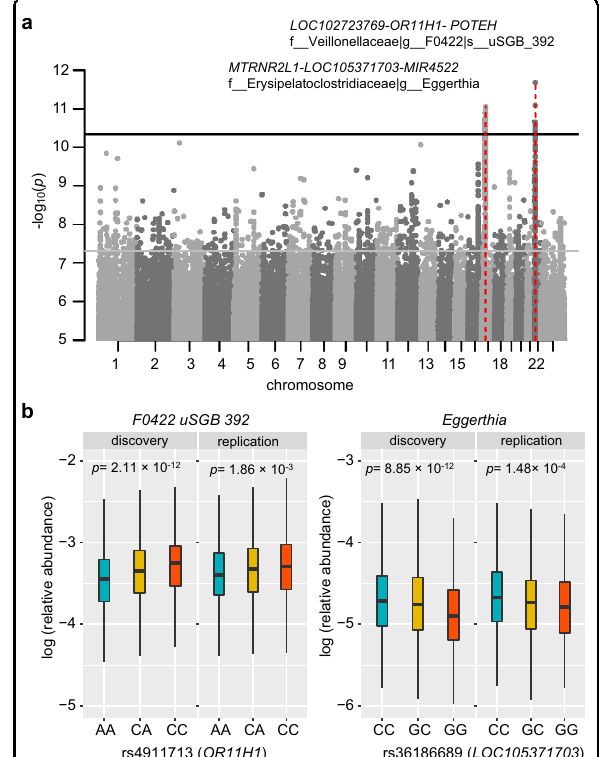
Fig. 4 Host genetic signals associated with the salivary microbiome. a Manhattan plot shows the genetic variants associated with the salivary microbial taxa. The horizontal gray and black lines represent the genome-wide ( p = 5 × 10 − 8 ) and study-wide ( p = 2.97 × 10 − 11 for 1685 independent mgGWAS tests) signi fi cance levels, respectively. Two loci that were associated with the salivary microbiome and reached study-wide signi fi cance were marked in red. b Their located genes and associated microbial taxa with p values of < 2.97 × 10 − 11 were also